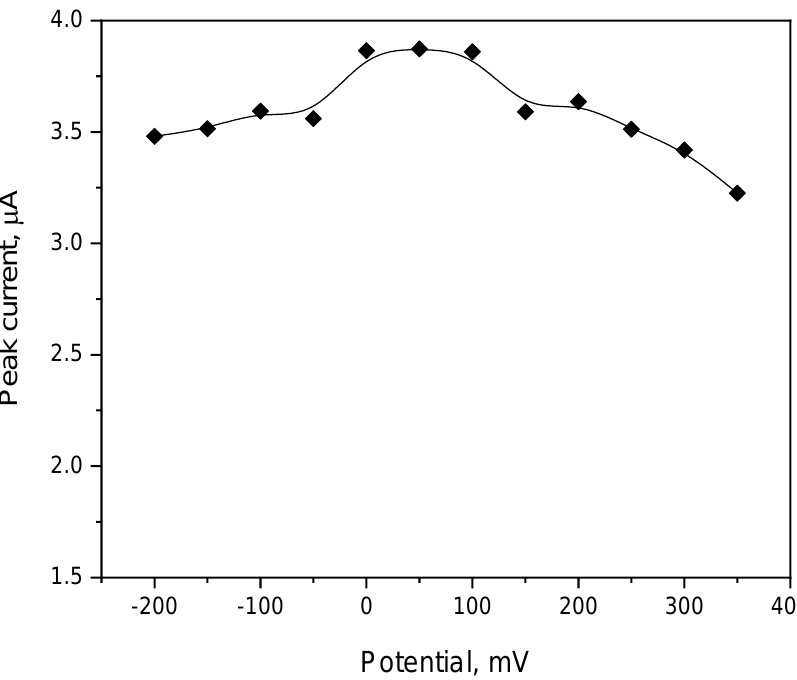
Figure 5. The influence of the preconcentration potential on VOR peak current value. Other instrumental parameters as in point 2.7.